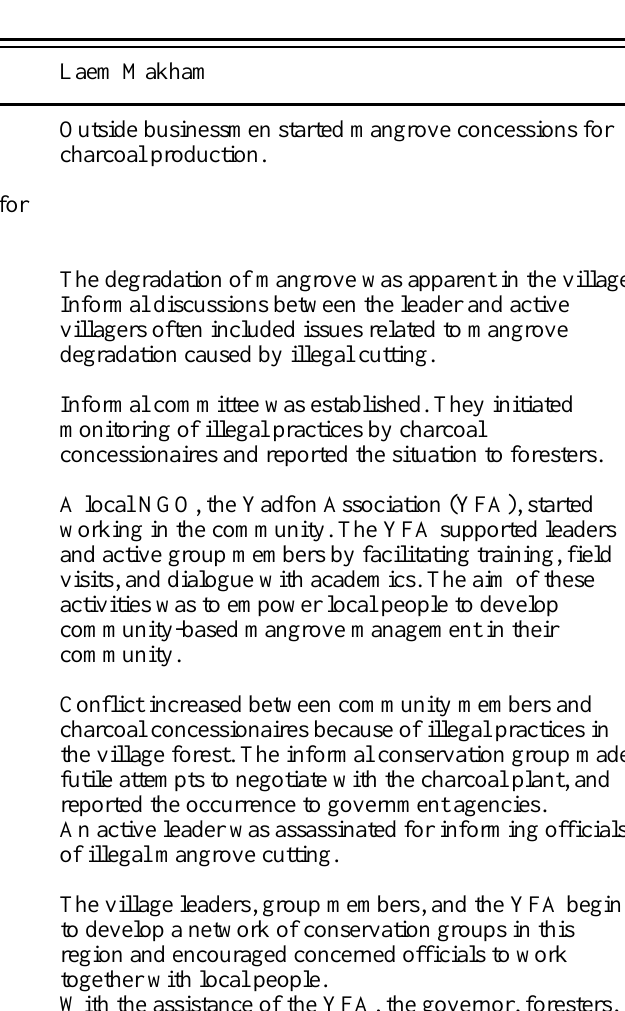
Table 1. Important historical events related to mangrove community forest establishment at two sites in Trang, southern